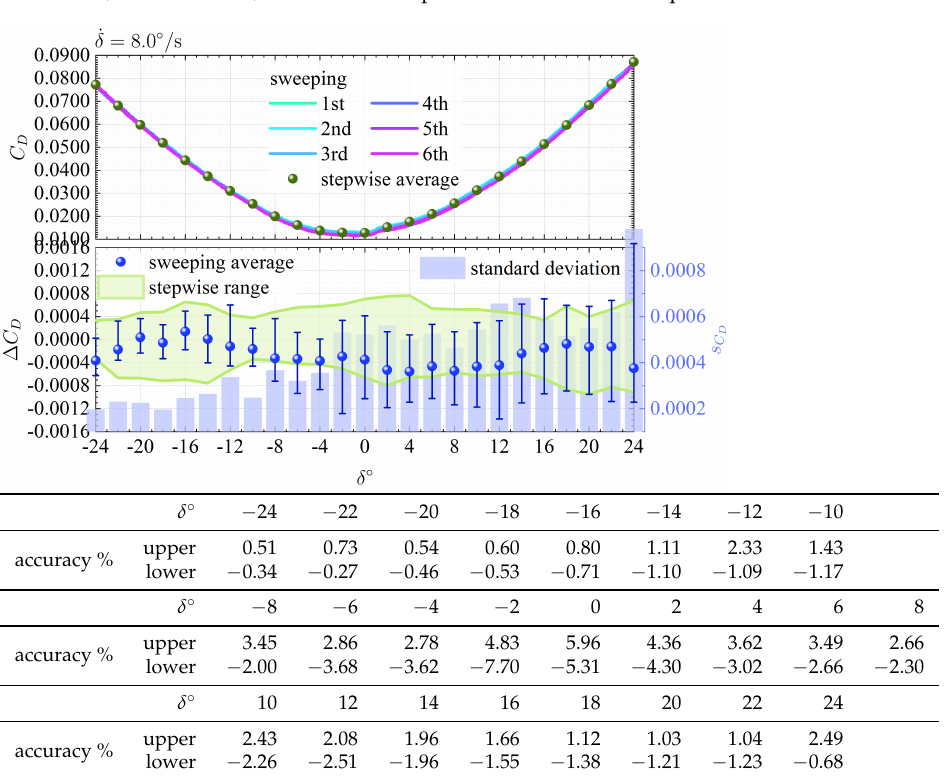
Figure 6. The results from a preliminary attempt in the sweeping mode under the conditions of ˙ δ = 4.0 ◦ /s, U ∞ = 40 m/s, and α = 0 ◦ compared with that in the stepwise mode.